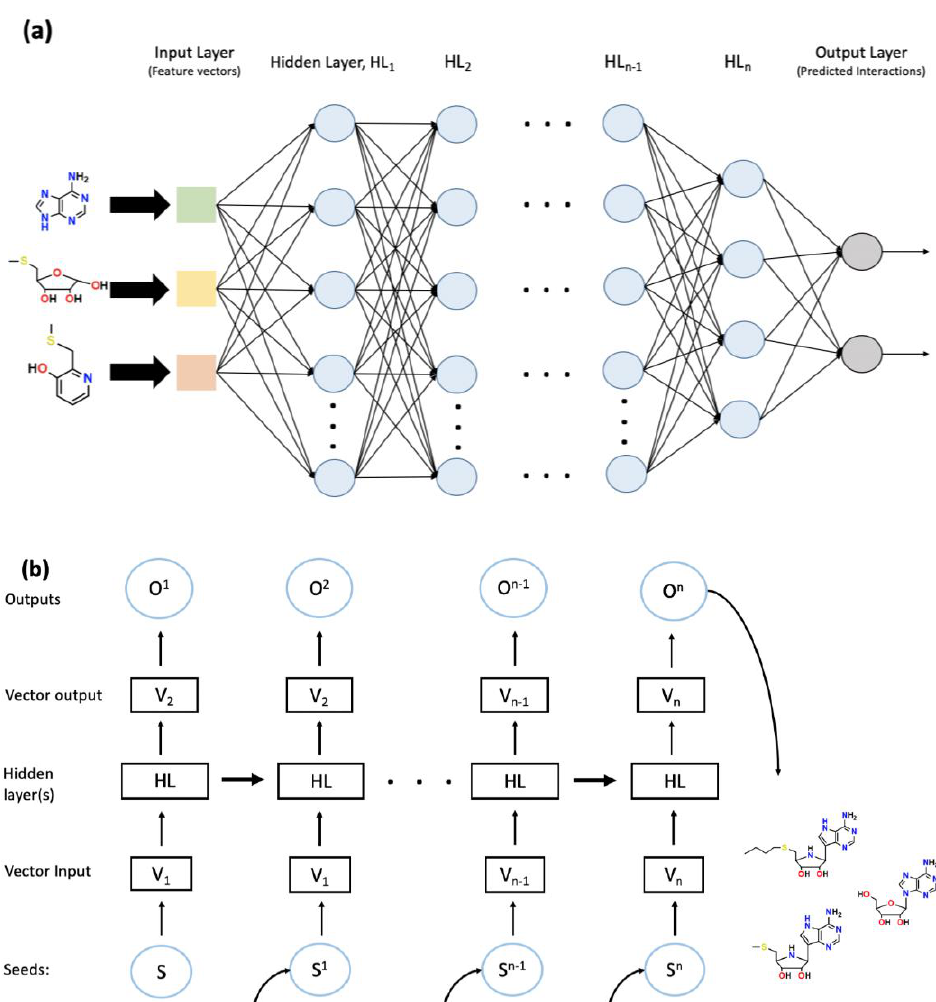
Figure 3. The general scheme of deep neural network (DNN) ( a ) and recurrent neural network (RNN) ( b ). ( a ) DNN consists of an input layer followed by several hidden layers and an output layer. In this case, the input layer utilizes feature vectors generated by a convolutional network. The progression of the NN follows a single path through hidden layer 1 (HL 1 ) to HL n, indicating the feedforward nature of the NN. The generated outputs are often processed using supervised learning techniques for the identification and collection of sensible interactions. ( b ) RNN begins with a seed, S, which is inputted into the system. Through the use of algorithmic processing, the seed is turned into a reference vector, V1, which is used by the HL to generate a vector output, V2. V2 is subsequently optimized through input training sets and creates the output, O. The generation of these outputs eventually leads to the creation of a gatherable data set. In the meantime, the HLs feed forward to provide information from previous steps. One example is chemical structure generation using SMILE string characters as seeds; hence the desired gathered outputs would be a string of SMILE characters that would be the desired structure. The dataset created in the figure is gathered and analyzed into the resultant